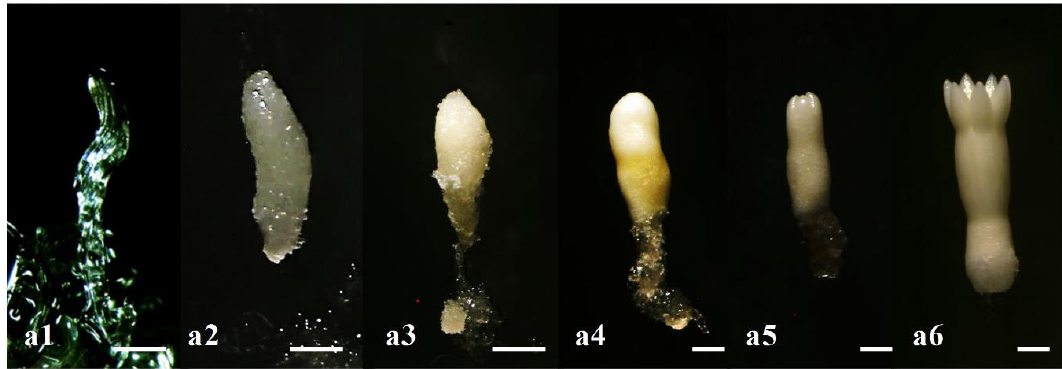
Figure 3. Korean pine somatic embryo development. ( a1 ) Somatic embryos cultured on maturation medium for 1 week. ( a2 ) Somatic embryos cultured on maturation medium for 2 weeks. ( a3 ) Somatic embryos cultured on maturation medium for 3 weeks. ( a4 ) Somatic embryos cultured on maturation medium for 4 weeks. ( a5 ) Somatic embryos cultured on maturation medium for 5 weeks. ( a6 ) Somatic embryos cultured on maturation medium for 8 weeks (Bar = 1 mm).